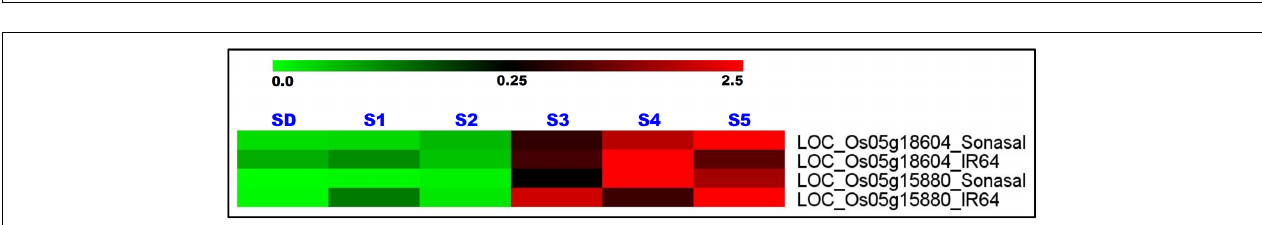
FIGURE 3 | The integration of genetic linkage map (A) with physical (B) map of a target genomic region harboring one major grain weight QTL ( OsqGW5.1 ) identified and mapped on 3.96 Mb sequence interval (between the flanking markers PMS2802 and PMS2849, indicated with red color) of rice chromosome 5. (C) The OsqGW5.1 QTL region-specific high-resolution integrated SSR and SNP marker-based QTL-seq analysis identified three major QTLs, OsqGW5.1 a (between the flanking markers PMS2802 and PMS2849), OsqGW5.1 b [SSR(AT) 41 and SNP (C/T)] and OsqGW5.1 c [SNP(A/G) and SNP(C/T)]. Subsequently, the integration of traditional QTL mapping with QTL region-specific (cid:49) (SNP/SSR-index)-based QTL-seq analysis narrowed-down the 3.96 Mb OsqGW5.1 major QTL region into a shorter 1.83 Mb OsqGW5.1 c sequenced QTL region (between flanking markers SNP (A/G)-SNP (C/T), marked with green color) on chromosome 5. (D) Two regulatory SNPs (A/G and C/T)-containing candidate genes [LOC_Os05g15880 (glycosyl hydrolase) and LOC_Os05g18604 (serine carboxypeptidase)] annotated within a novel 1.83 Mb sequenced major OsqGW5.1 c QTL interval exhibited strong association with rice grain weight according to (cid:49) (SNP-index)-based QTL-seq study. The genetic (cM)/physical (bp) distance and identity of the markers mapped on the chromosomes are indicated on the left/right side of the chromosomes, respectively. The details regarding SNPs (green color) and SSRs (blue and black colors) flanking/localized at the major grain weight QTLs are mentioned in the Table 2 and Supplementary Table S2.